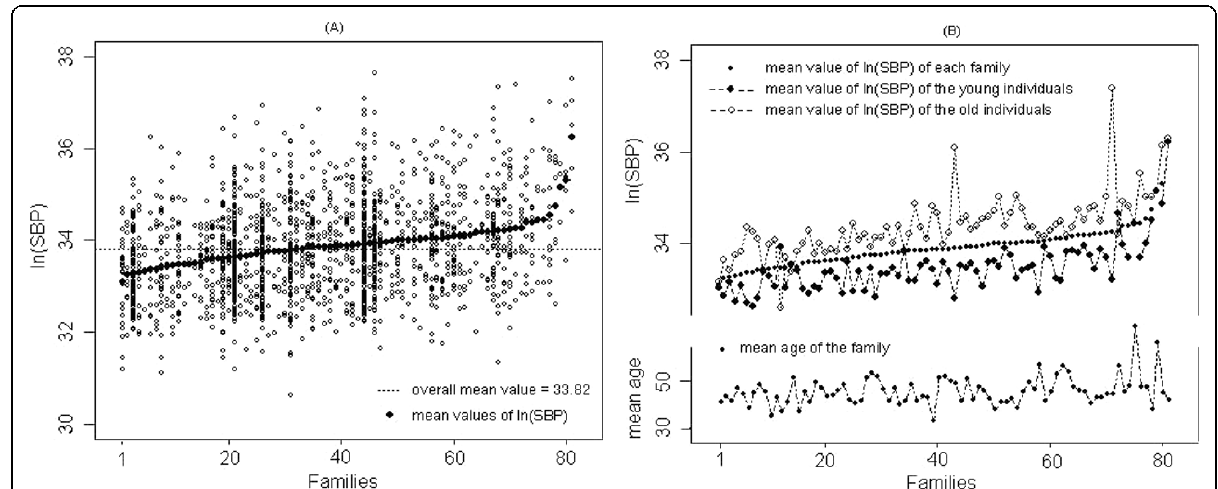
Figure 3 Values and mean values of ln(SBP) plotted for the Brazilian families . (A) Values of ln(SBP) plotted for the 81 families where the families are placed in order of their respective mean values. The horizontal dashed line represents the overall mean value of the families. (B) Mean values of ln(SBP) plotted for each family and for young and old individuals within each family, and the mean age profile of the